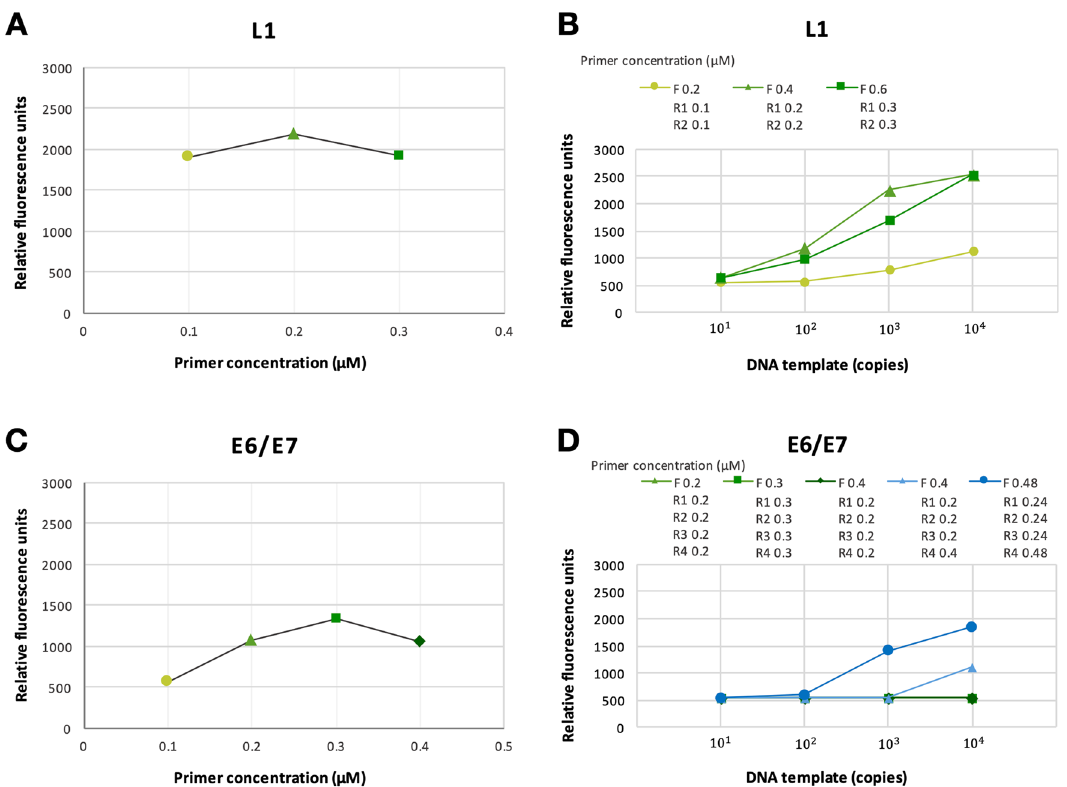
Figure 3. Fluorescent quantitation to validate optimal range of primer concentrations in 1-gene PCR reactions ( A and C , L1 and E6/E7) and multiplex 2-gene PCR reactions ( B and D ). In ( A and C ), individual primers were added at specified 0.1–0.4 µM on X-axis and synthetic L1 (or E6/E7) amplicons at > 10 8 copies were used as template. For ( B and D ), primers were added following primer concentration selections from Table 3 and synthetic L1 (or E6/E7) amplicons at 10 1 , 10 2 , 10 3 and 10 4 copies were used as